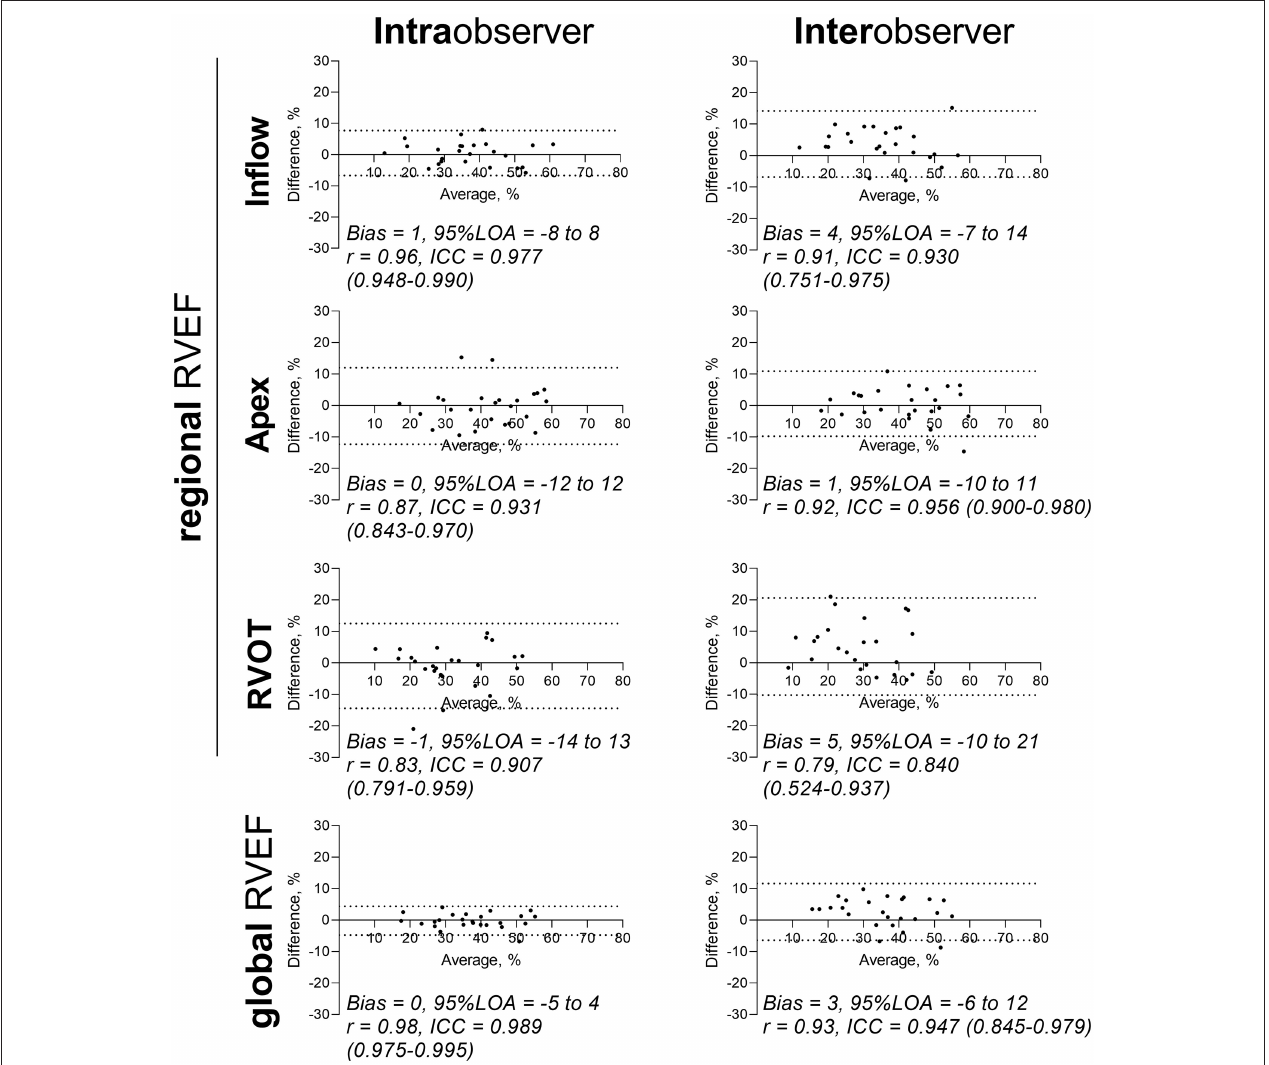
FIGURE 4 | Reproducibility analysis of global and regional RVEF measurements. Intraobserver and interobserver analysis of n = 25 patient meshes. Bland–Altman diagrams are displayed for global and regional RVEFs with biases, 95% limits of agreement (95% LOA), correlation coefficients r and intraclass correlation coefficients (ICCs) with 95% confidence intervals. ICC, intraclass correlation coefficient; LOA, limits of agreement; r, Pearson correlation coefficient; RVEF, right ventricular ejection fraction; RVOT, right ventricular outflow